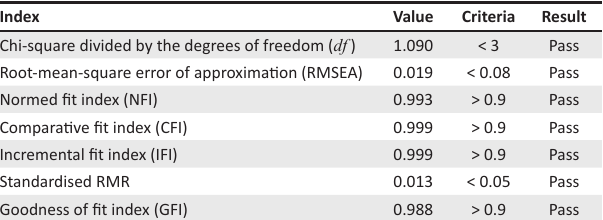
TABLE 2: Goodness-of-fit statistics for improved Utrecht Work Engagement Scale-9